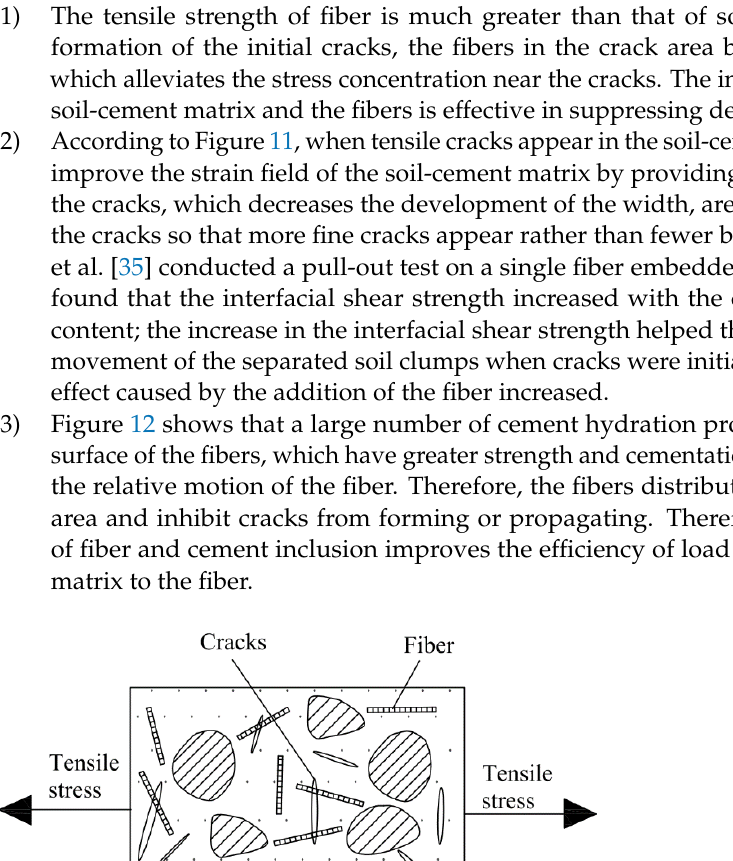
Figure 1 0 . SEM images of fiber and soil-cement matrix interface: ( a ) jute fiber; ( b ) PVA fiber.